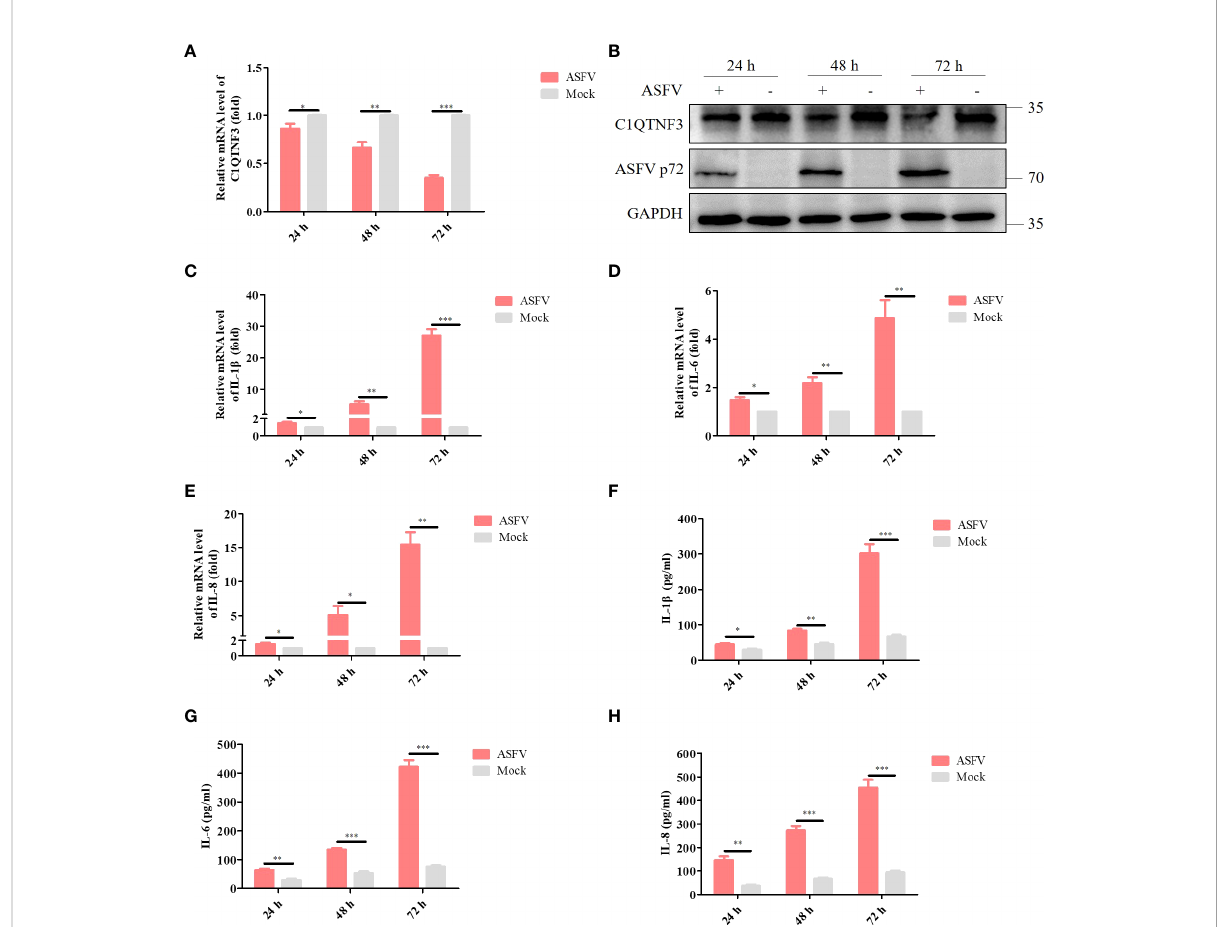
FIGURE 4 Expression of C1QTNF3 and pro-in fl ammatory factors IL-1 b , IL-6, and IL-8 in ASFV-infected and mock-infected PAMs at 24, 48, and 72 h post- infection. The mRNA levels of (A) C1QTNF3, (C) IL-1 b , (D) IL-6, and (E) IL-8 in ASFV-infected and mock-infected PAMs. The GAPDH gene was used as the internal control for normalization. The 2 - DD Ct method was used to analyze the results of qPCR. The protein levels of (B) C1QTNF3, ASFV p72 (F) IL-1 b , (G) IL-6, and (H) IL-8 in ASFV-infected and mock-infected PAMs p <0.05 (*), p < 0.01 (**), and p < 0.001